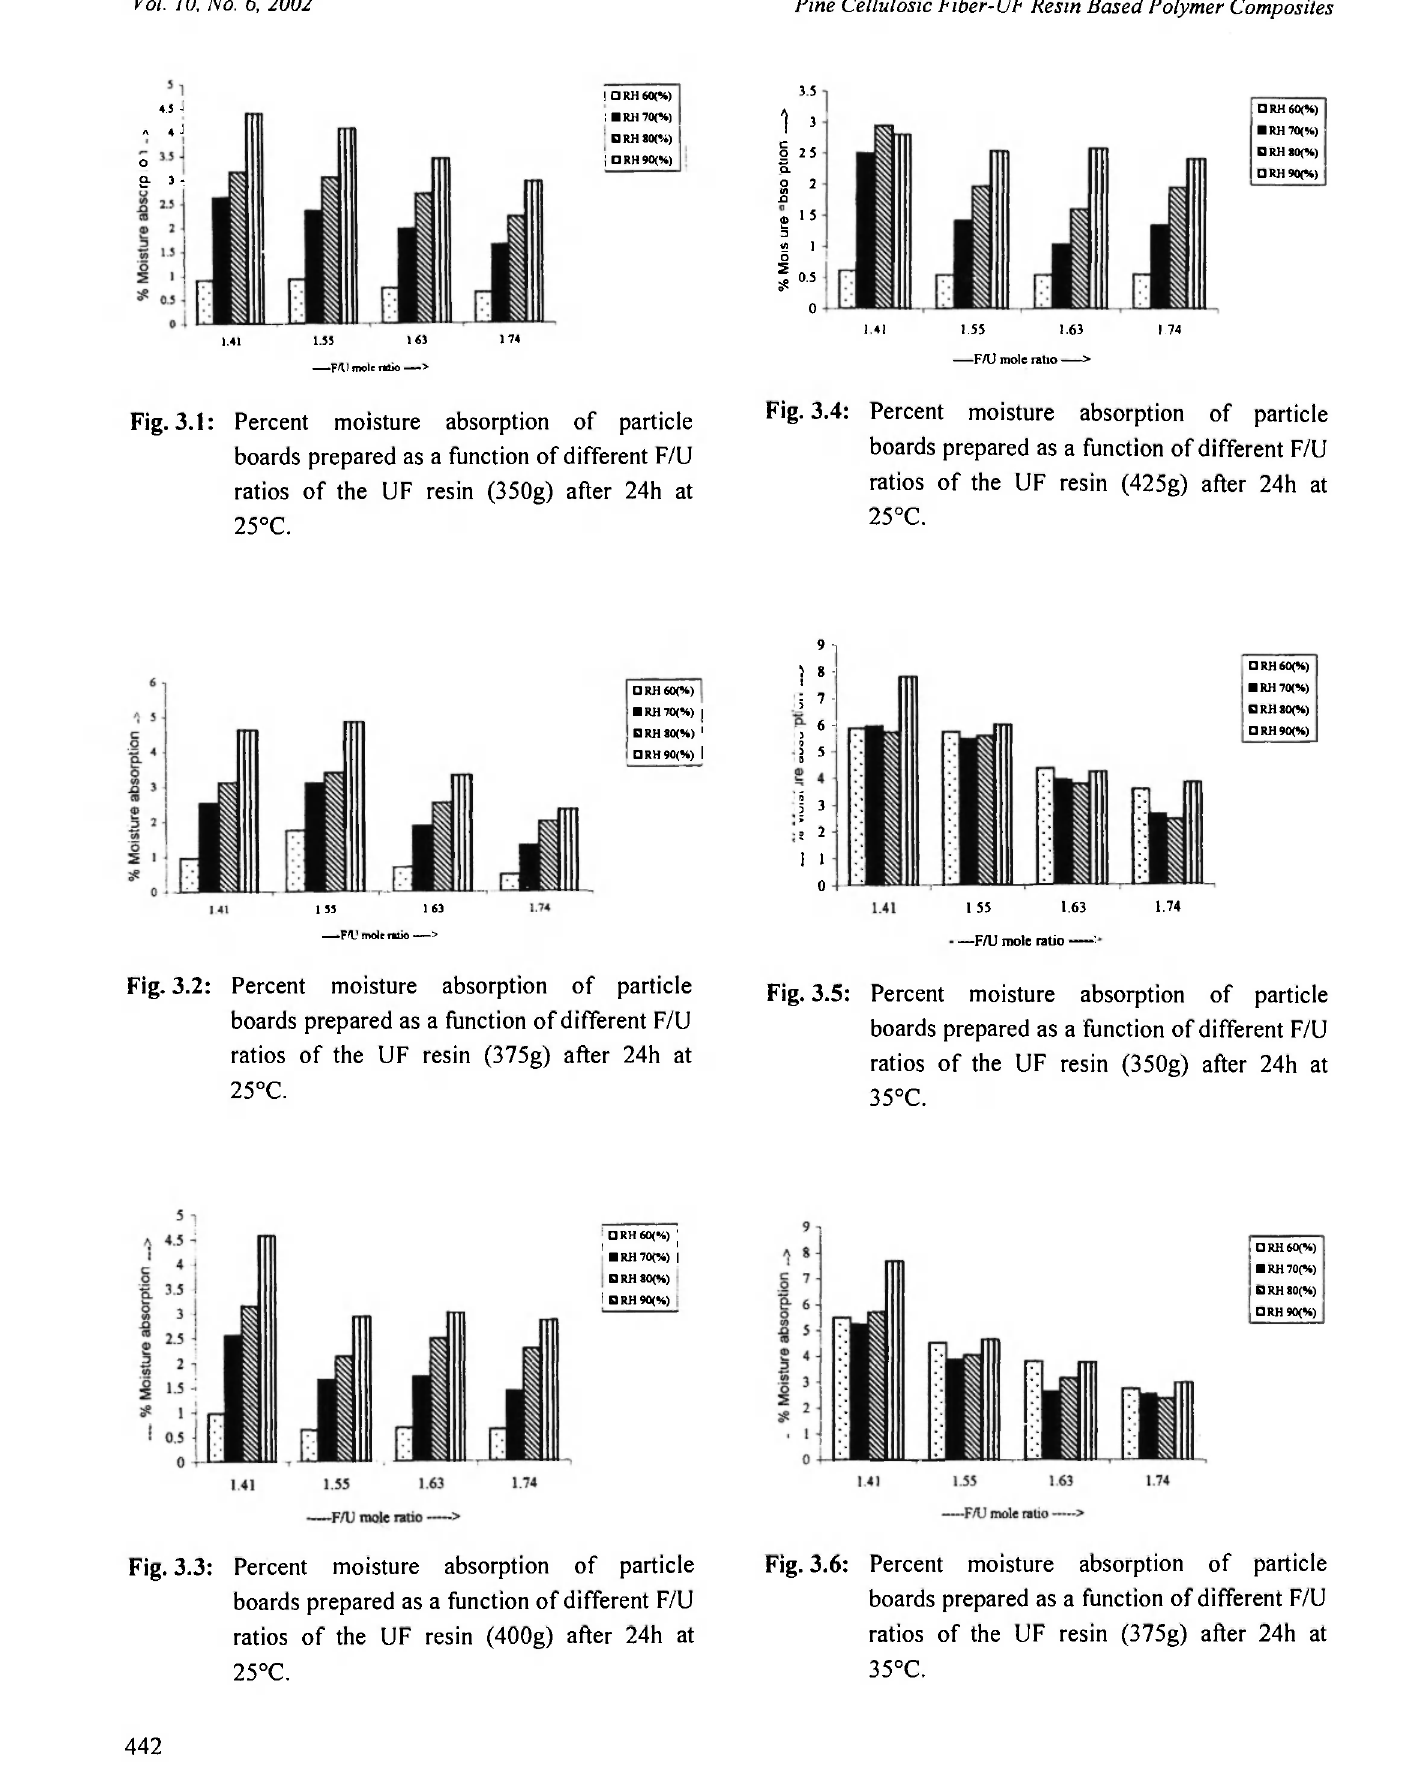
Fig. 3.3: Percent moisture absorption of particle boards prepared as a function of different F/U ratios of the UF resin (400g) after 24h at 25°C.